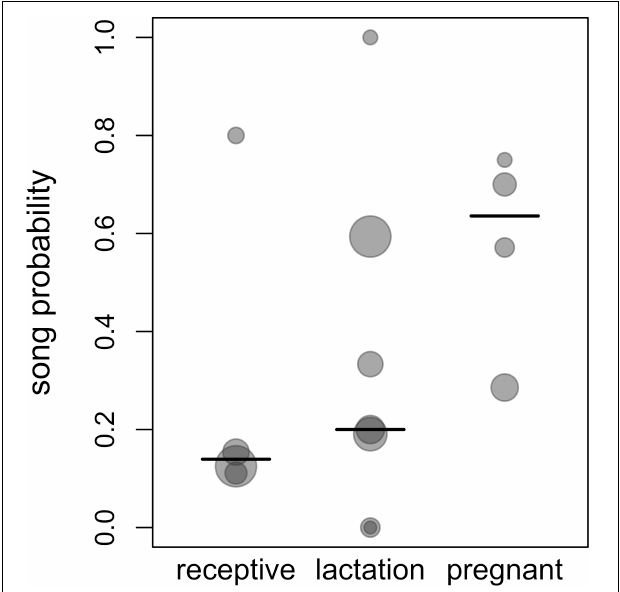
FIGURE 2 | Song probability for different female reproductive states. Shown are proportions of singing days of all observation days, with each dot corresponding to one group ID and the area of the dots increasing linearly with the respective sample size for a given group and a given reproductive state (3 to 32 observation days per each combination of reproductive state and group ID, total N = 171 observation days). The lines depict the median values for each reproductive